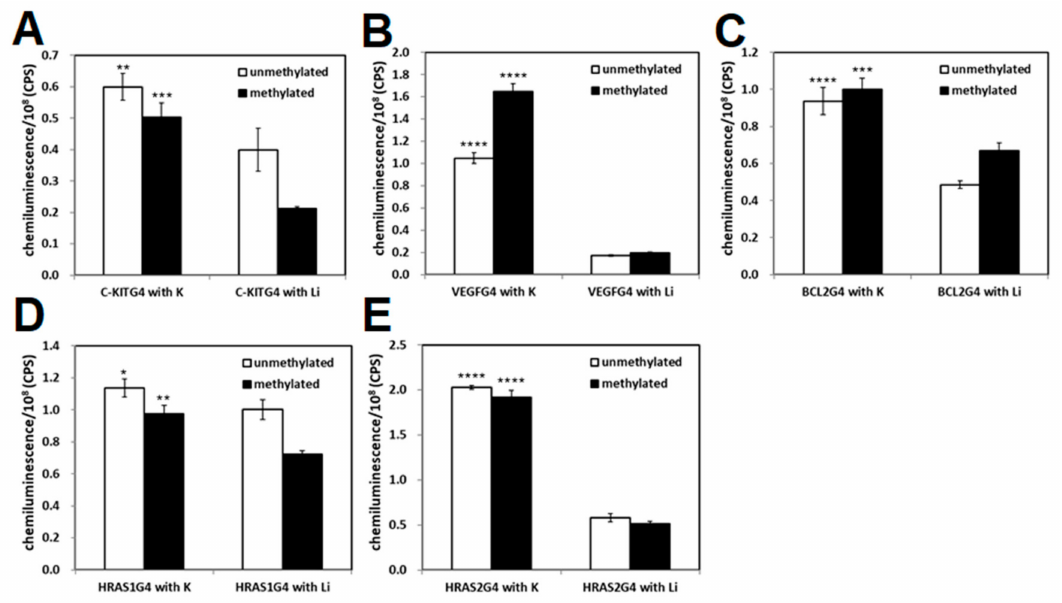
Figure 3. Binding ability of SP1 to c-KIT ( A ); VEGF ( B ); BCL-2 ( C ); HRAS1 ( D ); and HRAS2 ( E ) G4 DNAs in the presence of K + or Li + . Binding of GST-SP1 to G4 DNAs immobilized on the well was detected with an HRP-conjugated anti-GST antibody. As a negative control, a well without immobilized DNA was utilized. Bar plots mean values ± SD (N = 3). Statistical analyses were performed using two-way ANOVA with Tukey’s multiple comparisons post-hoc tests. The significance of differences of observed values from the Li + -treated group are indicated as follows: * p < 0.05; ** p < 0.001; *** p < 0.0005; **** p <